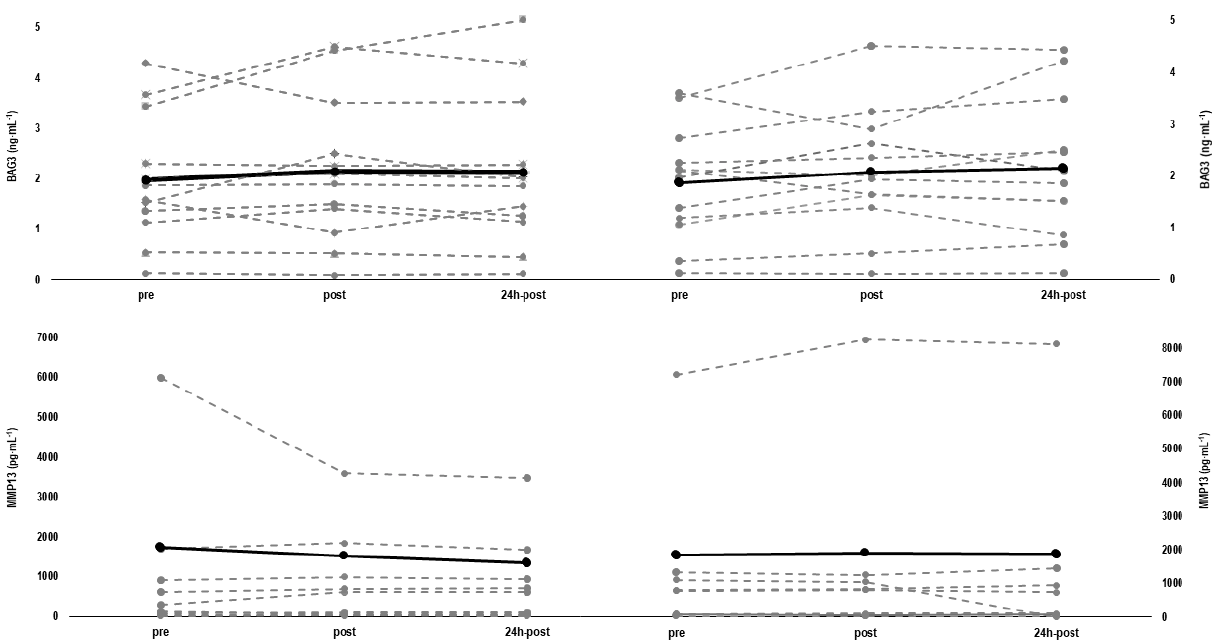
Figure 3. Individual relative changes and mean values (solid line) for collagenase matrix metalloproteinase 13 (MMP-13) ( n = 9) and BCL2-associated athanogene 3 (BAG3) ( n = 12) from baseline (pre), immediately after (post), and 24 h after (24 h-post) eccentric cycling (left panel) and concentric cycling (right panel).